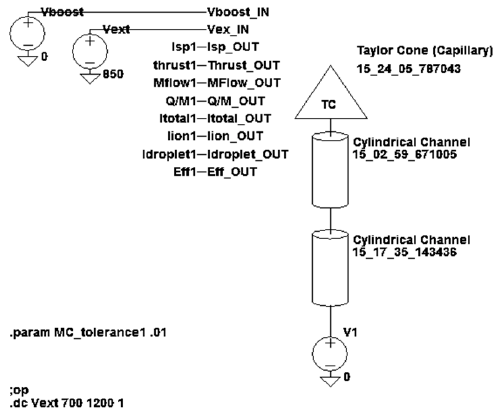
Figure 12. SPICE schematic for an emitter in the array developed by Dandavino et al. [1].